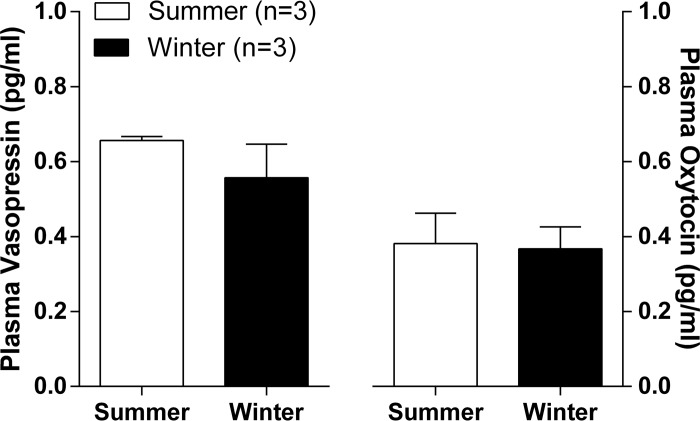
Circulating plasma AVP and OT levels are unchanged with season in hydrated males dromedary camels as determined by radioimmunoassay.